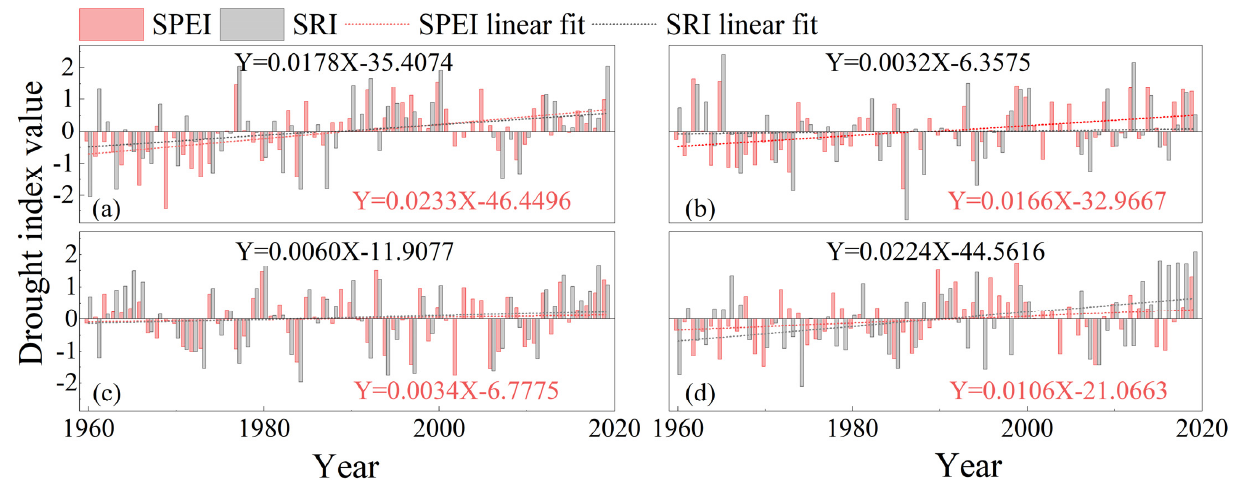
Figure 4. Interannual variation of drought intensity in different seasons in the YJB from 1960 to 2019. ( a – d ) indicate spring, summer, fall, and winter, respectively.